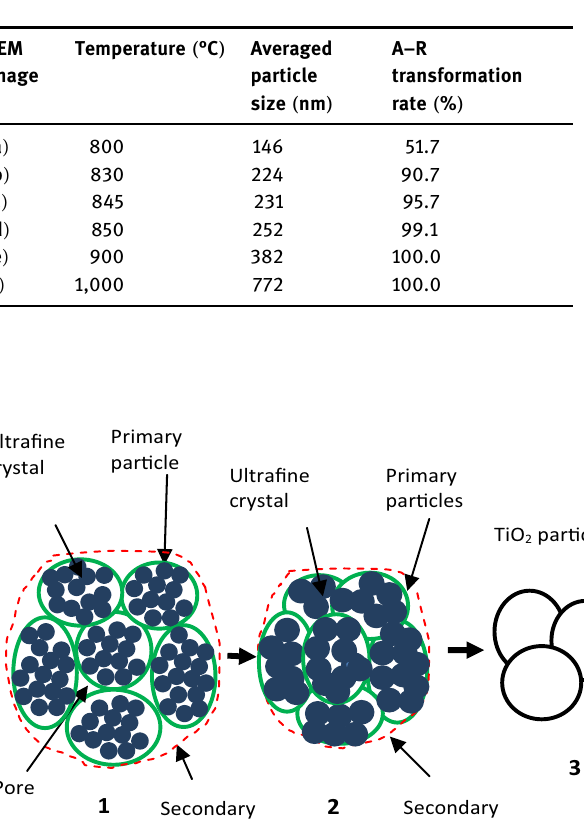
Table 2: Averaged particle size and anatase – rutile transformation rate of metatitanic acid during calcinations